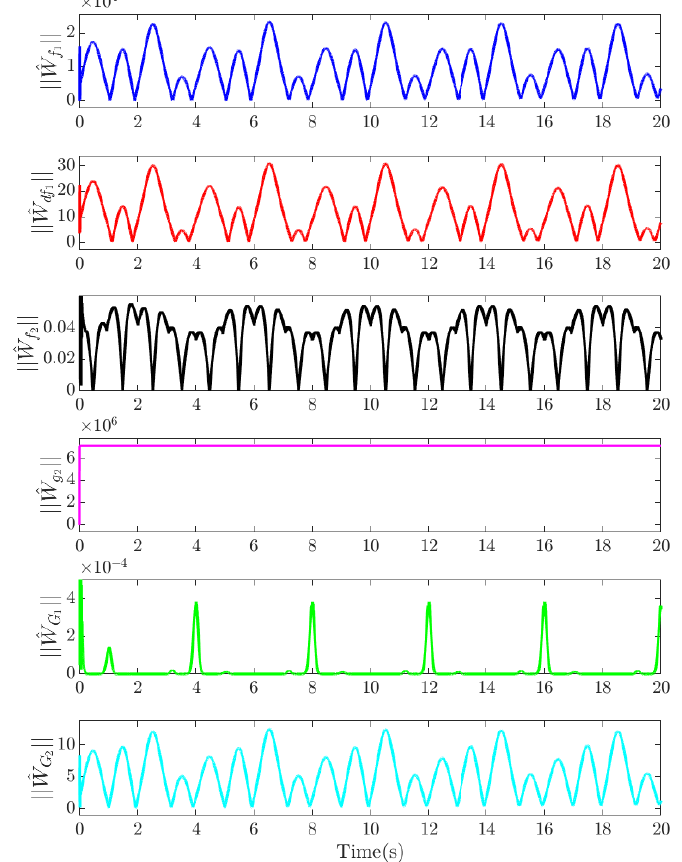
Figure 6. The weighting values of RFB NNs employed of the proposed